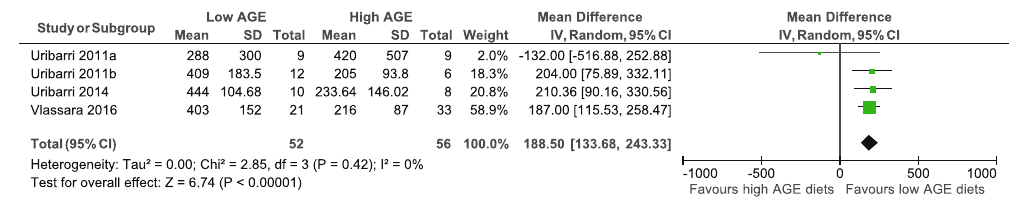
Figure 6. Meta-analysis of low AGE and high AGE diets for sirtuin-1 (mRNA): forest plot shows the effect of low AGE and high AGE diets on